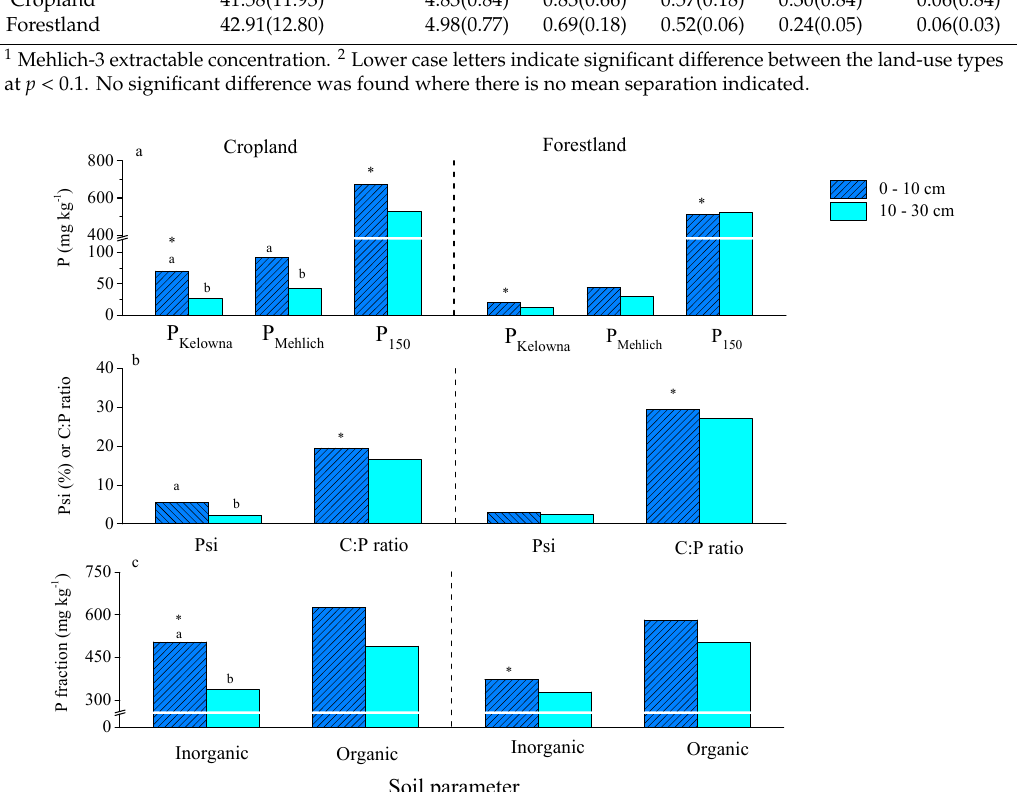
1 Mehlich-3 extractable concentration. 2 Lower case letters indicate significant difference between the land-use types at p < 0.1. No significant difference was found where there is no mean separation indicated.